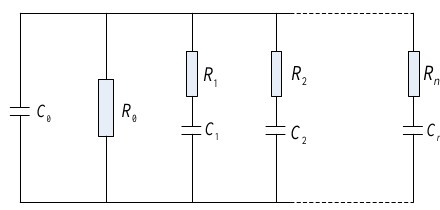
Figure 4. Extended Debye model for transformer oil-paper insulation.